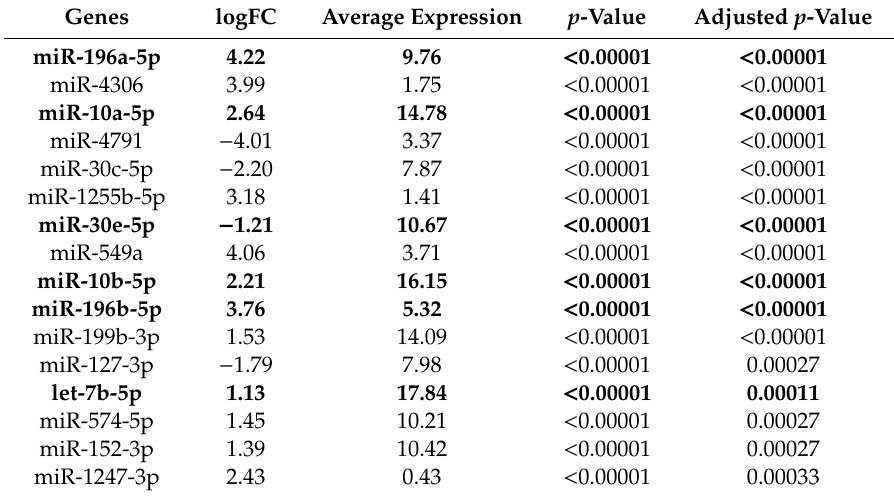
Table 2. MicroRNAs with the most significantly di ff erent levels in cerebrospinal fluid of glioblastoma patients in comparison to controls ( p < 0.001) supplemented with additional miRNAs tested in the validation phase of the study listed at the bottom of the table (in italics). All miRNAs selected for the validation phase are in bold; and logFC = binary logarithm of Fold